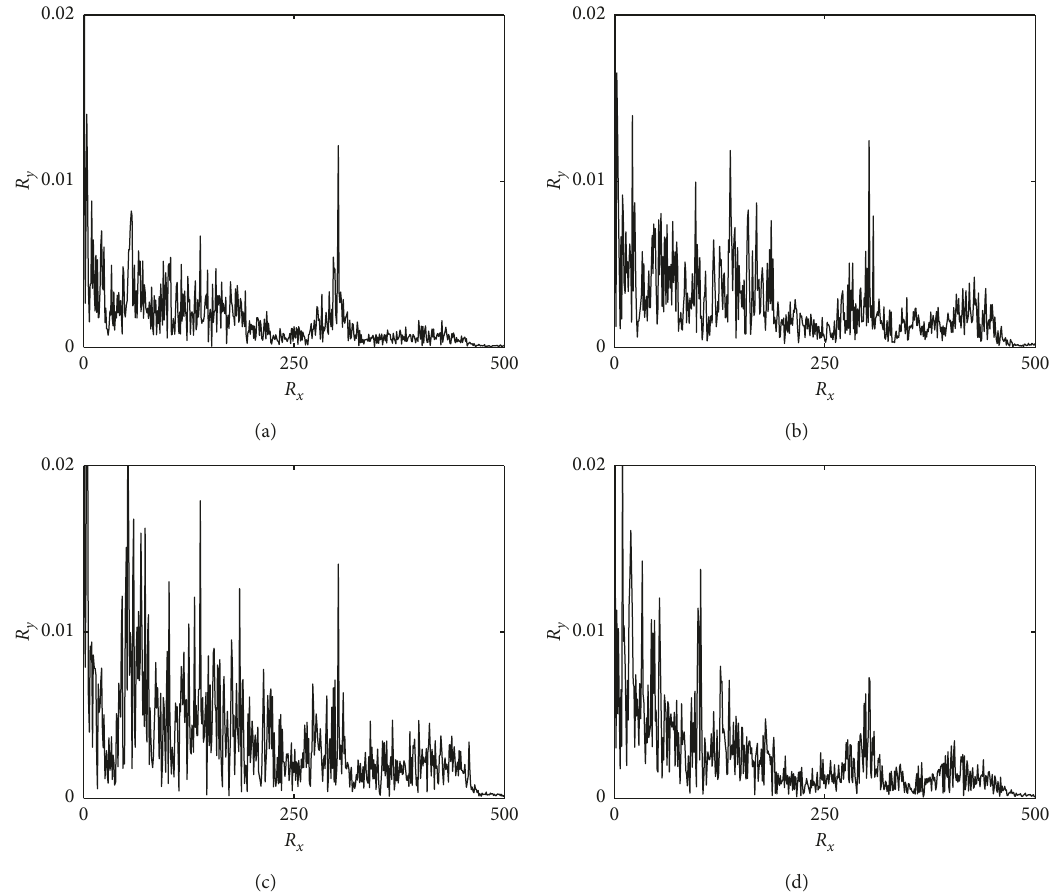
Figure 9: The adjusted spectrum images of dataset C: (a) NO; (b) IF; (c) OF; (d)